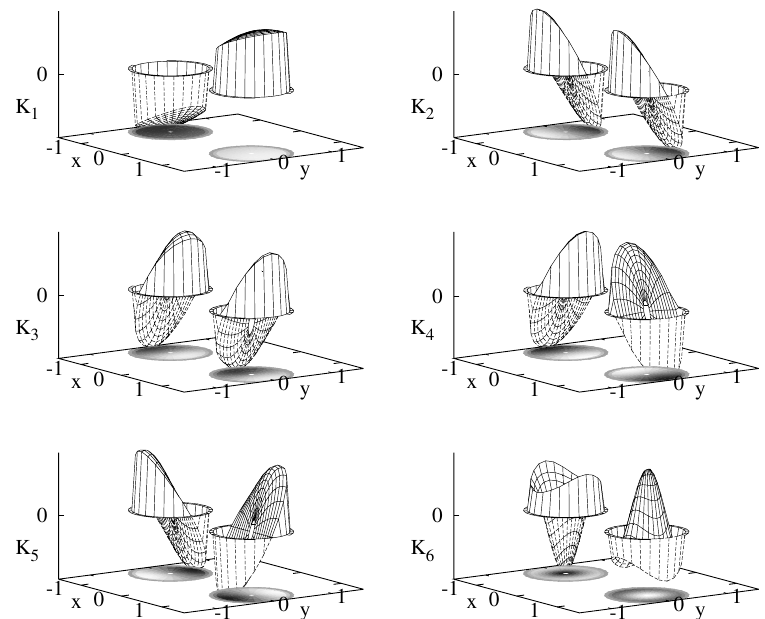
Fig. 5. The basis functions K 1 to K 6 for q = 1 = 2. (cid:21) 2 0.01659, 0.01372, 0.01286 and 0.00390 for j = 1 to 6. The total power is ∑ 90 (cid:21) 2 = 0 : estimated to j j =1